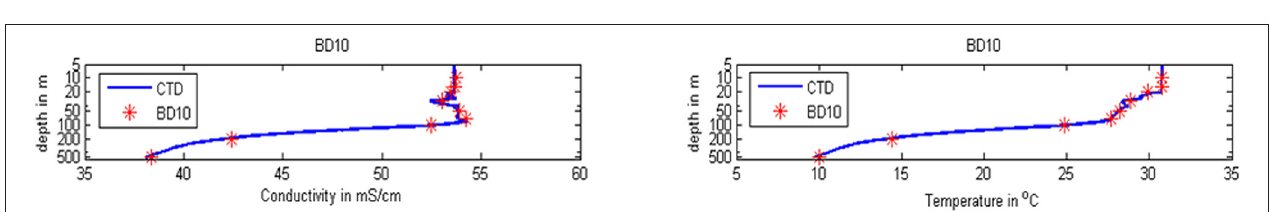
FIGURE 14 | CTD profile